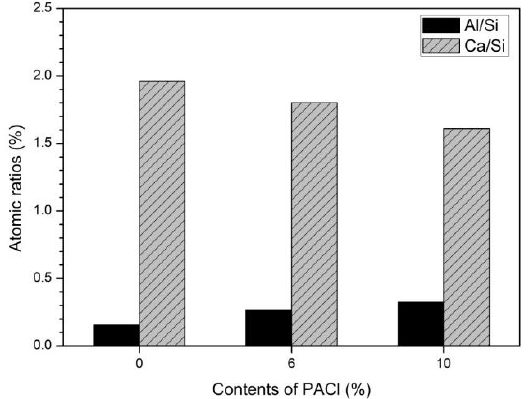
Figure 5. Atomic ratios of hydration products for 0%, 6%, and 10% PACl samples.